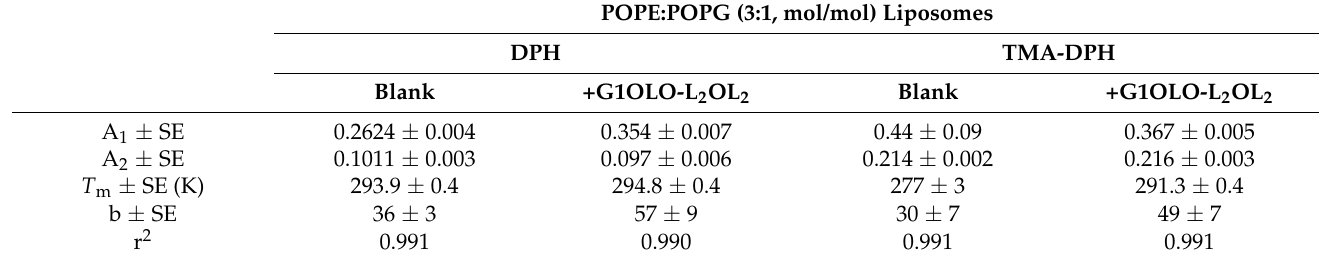
Table 2. Values of the experimental parameters obtained by fitting the data in Figure 2 to Equation (2). Measures were made by